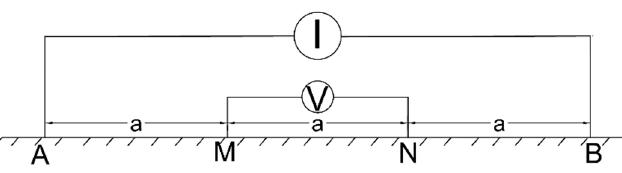
Figure 3. A schematic diagram of the Wenner array electrode configuration. ‘A’ and ‘B’ = current electrodes (I = current), ‘M’ and ‘N’ = potential electrodes (V = potential difference) and ‘a’ = spacing between electrodes. Table 1. Electrical resistivity survey plan.